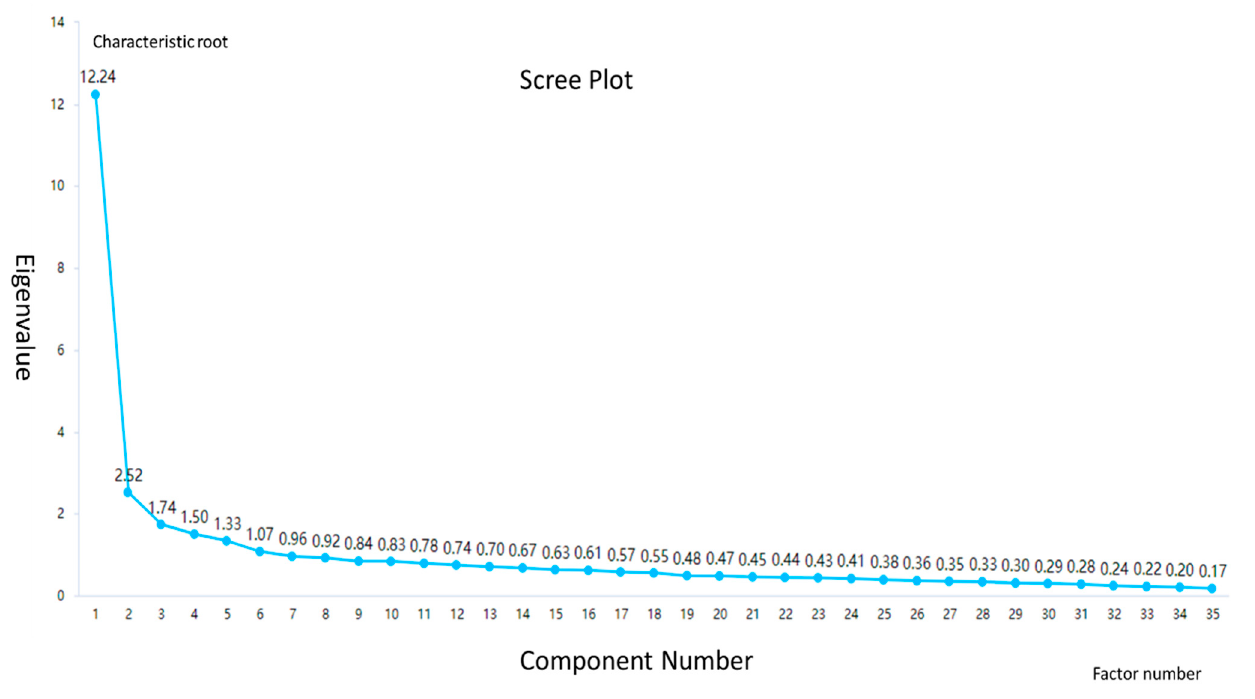
Table 1. The variance explanation of factor.